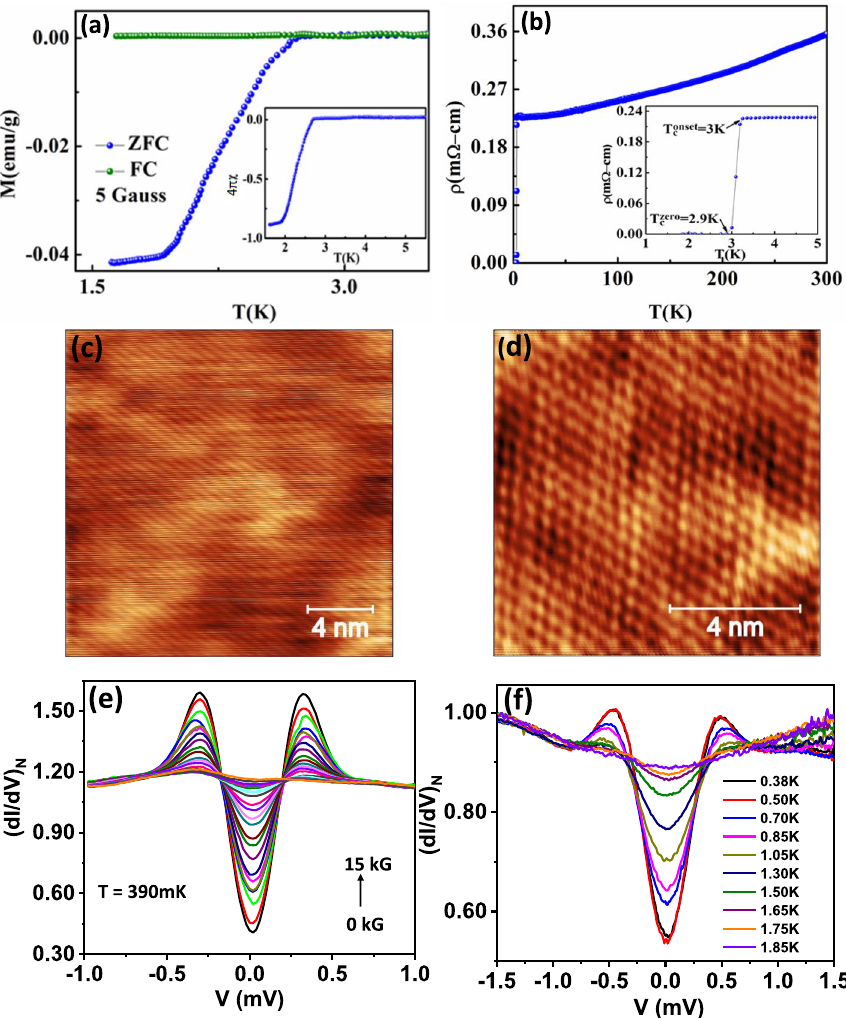
Figure 1. ( a ) Magnetization vs temperature (Zero field cooled (ZFC) and Field cooled (FC)). ( b ) Resistivity ( ρ ) as a function of temperature ( T ) of Sr 0.1 Bi 2 Se 3 . ( c ) STM topography of the Sr 0.1 Bi 2 Se 3 cleaved surface (20 nm × 20 nm). ( d ) Atomic resolution image (10 nm × 10 nm) of the Sr 0.1 Bi 2 Se 3 surface. ( e ) Temperature dependence of the STS spectra upto 1.85 K. ( f ) Normalized STS spectra with varying magnetic fields upto 15